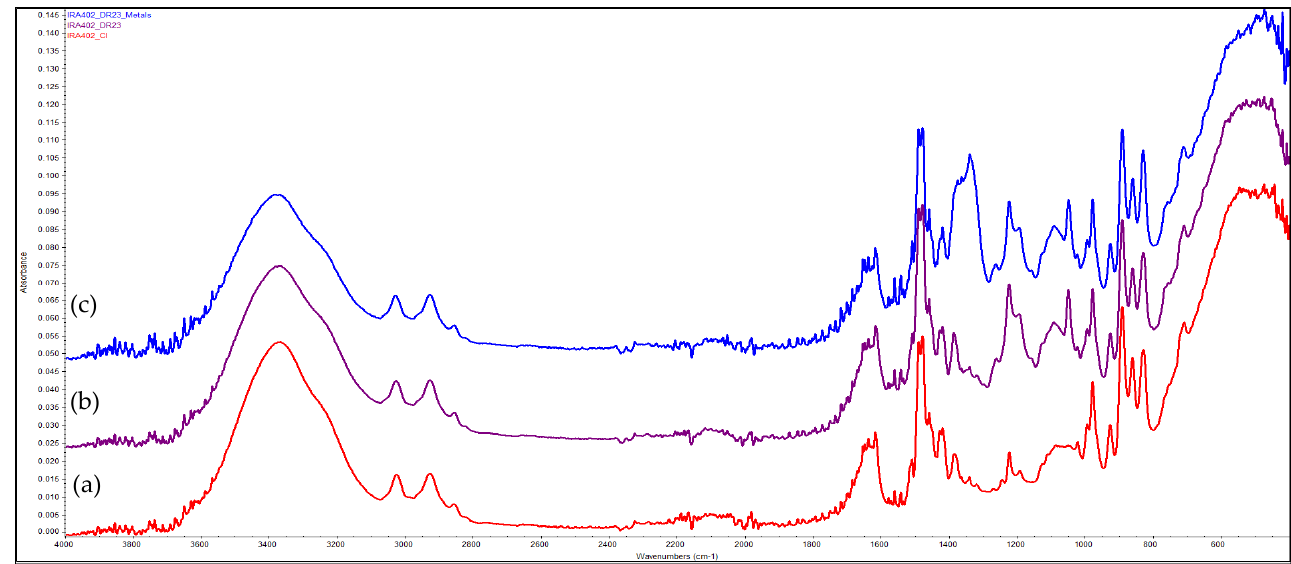
Figure 8. FTIR spectra of ( a ) IRA 402(Cl − ), ( b ) IRA 402-DR23 and ( c ) IRA 402-DR23-M 2+ .